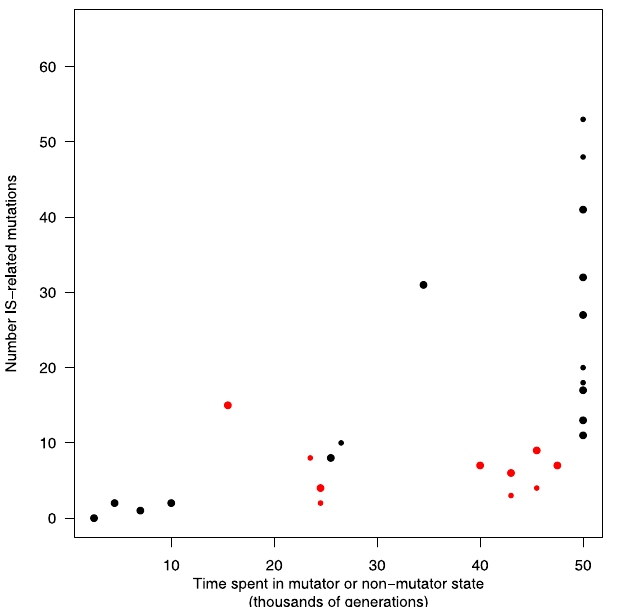
Fig. 4 Number of fi xed IS-related mutations as a function of a lineage ’ s time spent in mutator or non-mutator state. Large and small dots show mutations fi xed in major and minor lineages, respectively. (Both include mutations fi xed in the total population, so they are not fully independent). Red and black dots indicate mutator and non-mutator populations, respectively; the y -axis values show the number of IS-related mutations that were fi xed over the time spent in either the mutator or non-mutator state. Source data are provided as a Source Data fi le.